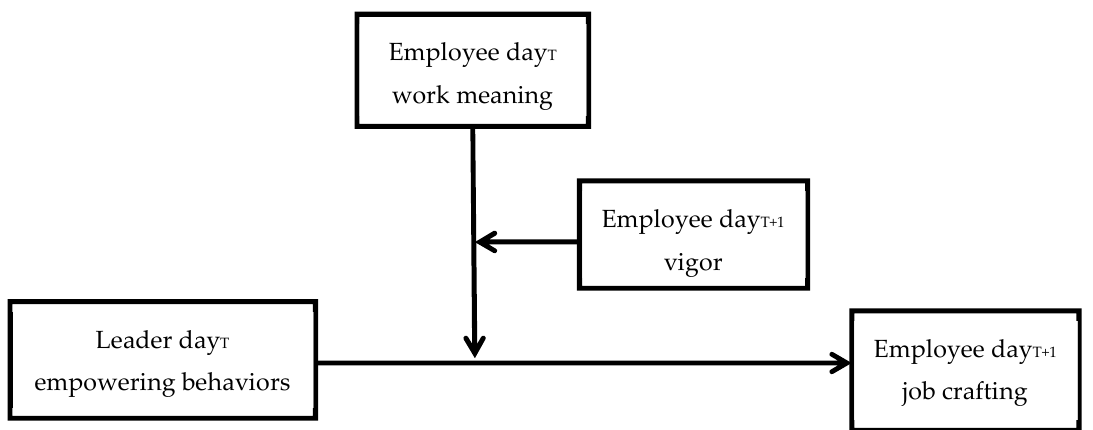
Figure 1. The proposed contingency model of daily leader empowering leadership and employee job crafting.